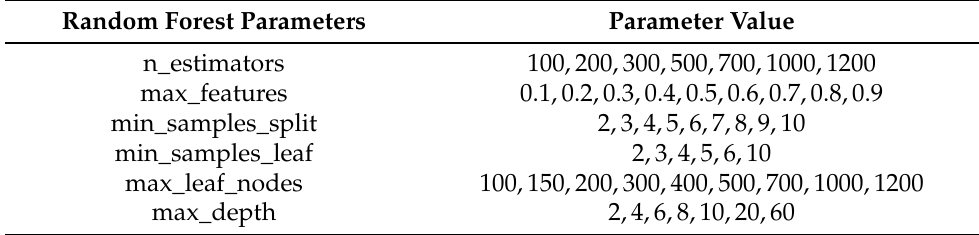
Table 1. Common parameter settings for random forests. Random Forest